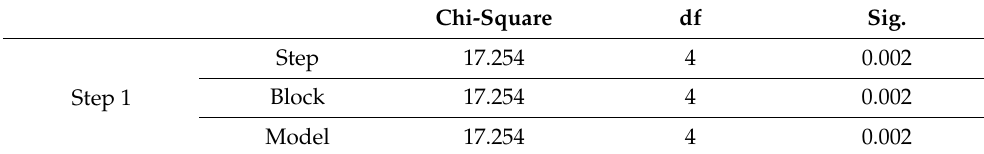
Table 12. Omnibus tests of model coefficients.